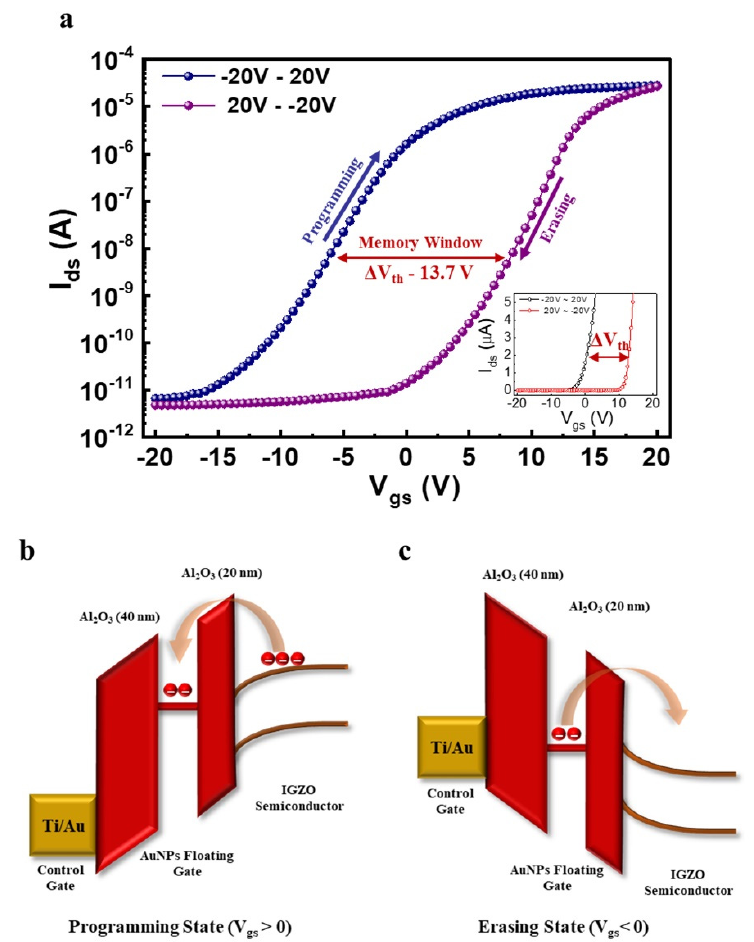
Figure 4. Transfer characteristics of the proposed NVM device. ( a ) A hysteresis of the transfer curve of the proposed NVM device when sweeping from − 20 V to +20 V back and forth, defines a memory window of 13.7 V. ( b , c ) A band diagram illustration of the proposed NVM device in case of programming and erasing when V gs > 0 V and V gs < 0 V, respectively.